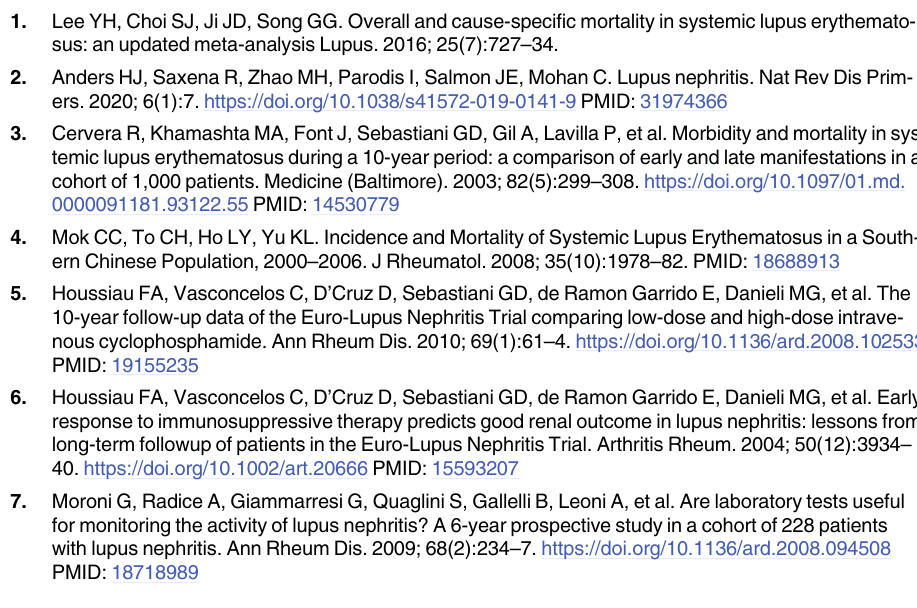
S1 Table. Data bases and search strategies used. S2 Table. Overview of reported cut-off thresholds used on primary studies in the included